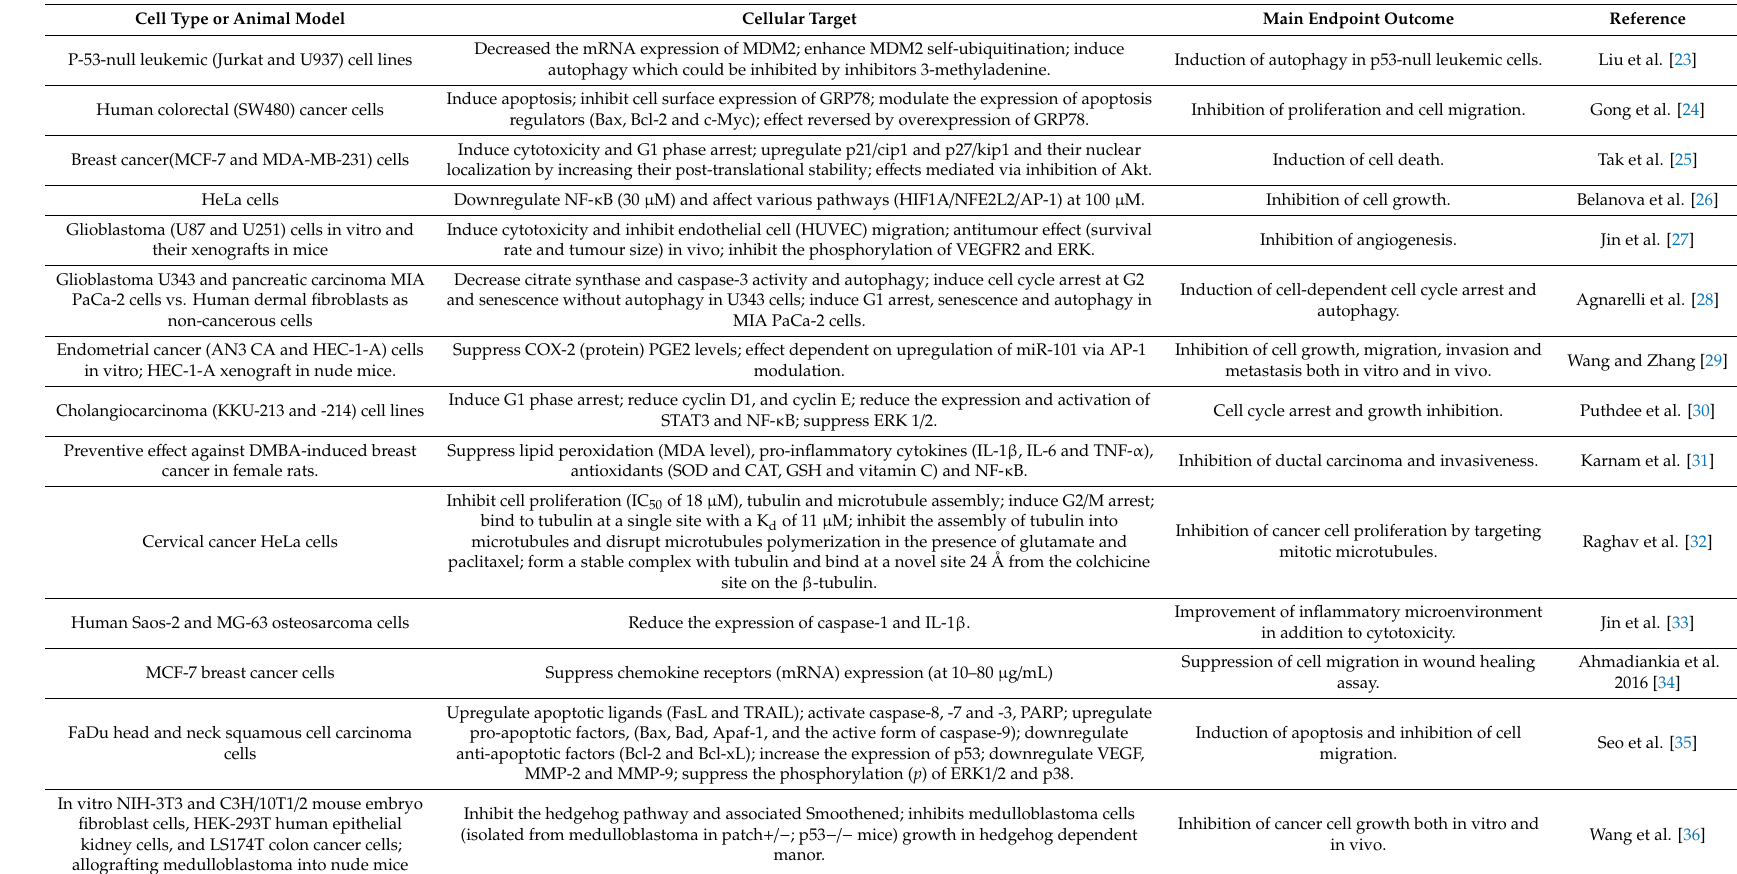
Table 1. Cellular targets of berberine as an anticancer